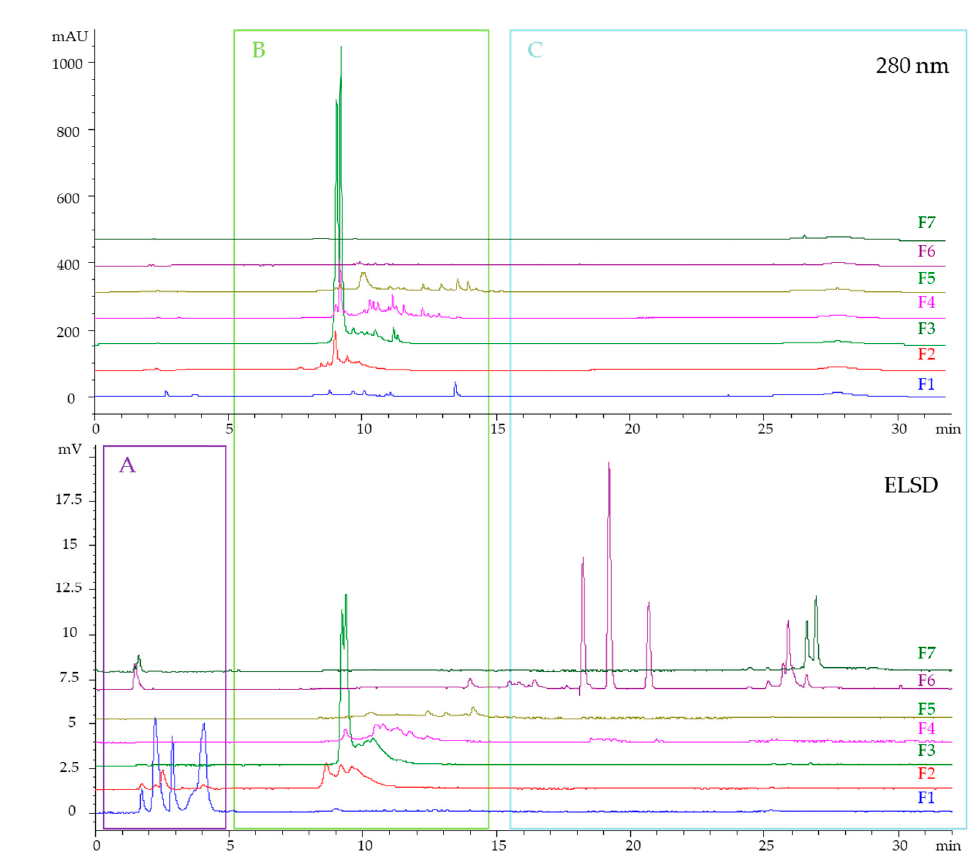
Figure 4. HPLC chromatograms obtained on a Luna ® C 18 column (150 × 4.6 mm; 5 µm) at 280 nm and with ELSD for the 7 fractions obtained by fractionation of the R. nigrum pomace extract (group A : polar molecules, group B : polyphenols, group C : terpenes, terpenoids and fatty acids).